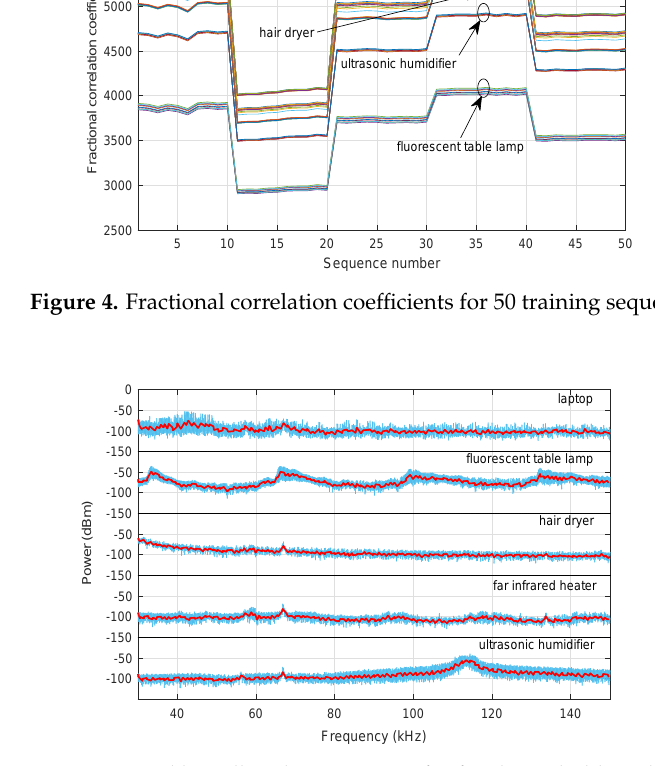
Figure 5. Fitted broadband components for five household